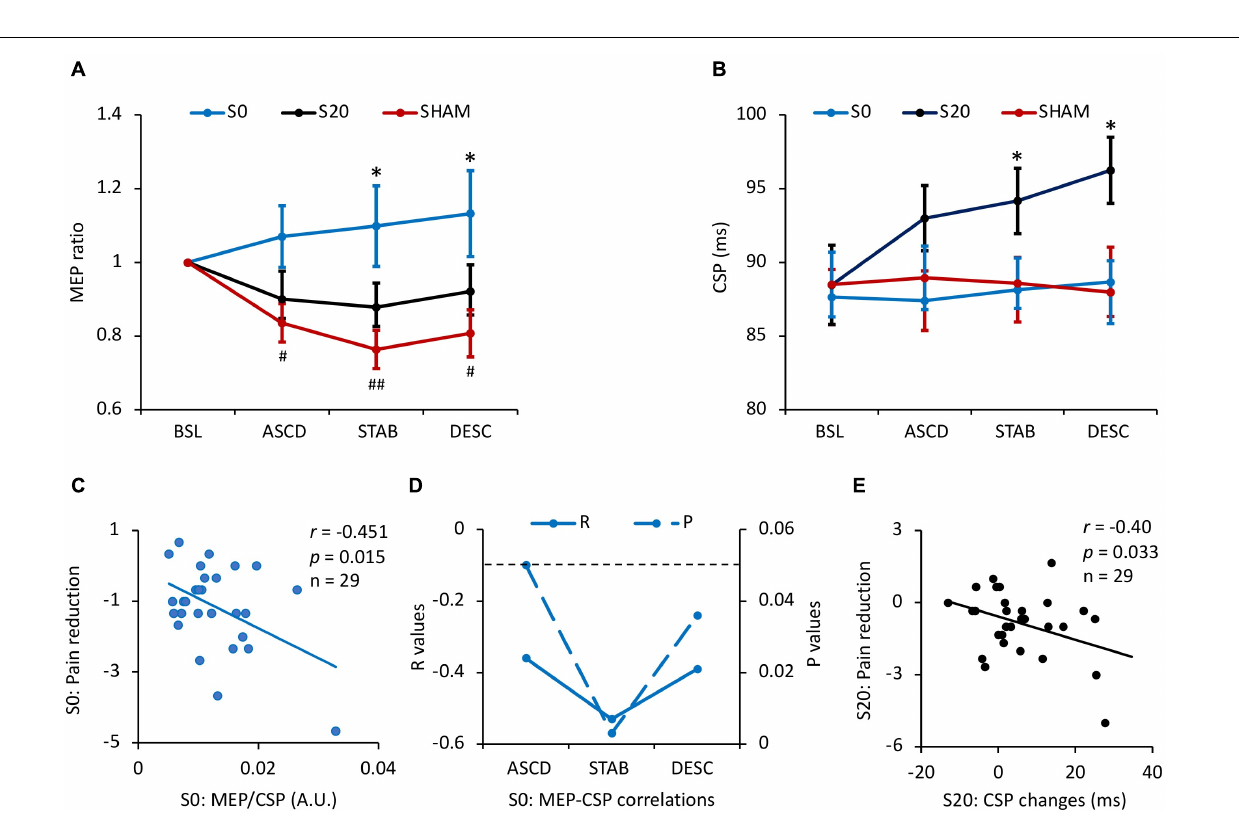
FIGURE 3 | Results of motorcortical excitability and the associations with pain reduction. (A) The effects of stimulation on MEP. Pain inhibited MEP in all stages compared to the baseline (all P corrected < 0.05) in the Sham condition, while pcTBS at S0 reversed depressed MEP in the stabilizing ( P corrected = 0.022) and descending stages ( P corrected = 0.024), and a trend increase in the ascending phase ( P corrected = 0.06). (B) The effects of pcTBS on CSP. CSP duration was increased by the S20-pcTBS in the stabilizing ( P corrected = 0.033) and descending (all P corrected = 0.015) stages compared to the Sham stimulation. (C) A significant negative correlation between the early (ascending) MEP/CSP ratio and late (descending) pain reduction in S0-pcTBS. (D) The dynamic correlations between MEP and CSP changes in the S0-pcTBS. MEP changes in the early phase (ascending) was negatively associated with CSP changes in the ascending, stabilization, and descending phases. (E) A significant negative correlation between the early (stabilization) CSP changes and late (descending) pain reduction in S20-pcTBS. ∗ represents P < 0.05 compared to Sham; # and ## represent P < 0.05 and P < 0.01 compared to the baseline. A.U. denotes arbitrary unit. The dash line denotes P < 0.05. Error bars represent mean ± SE; BSL, baseline; ASCD, ascending; STAB, stabilization; DESC, descending. All the correlations are presented with age regressed as a